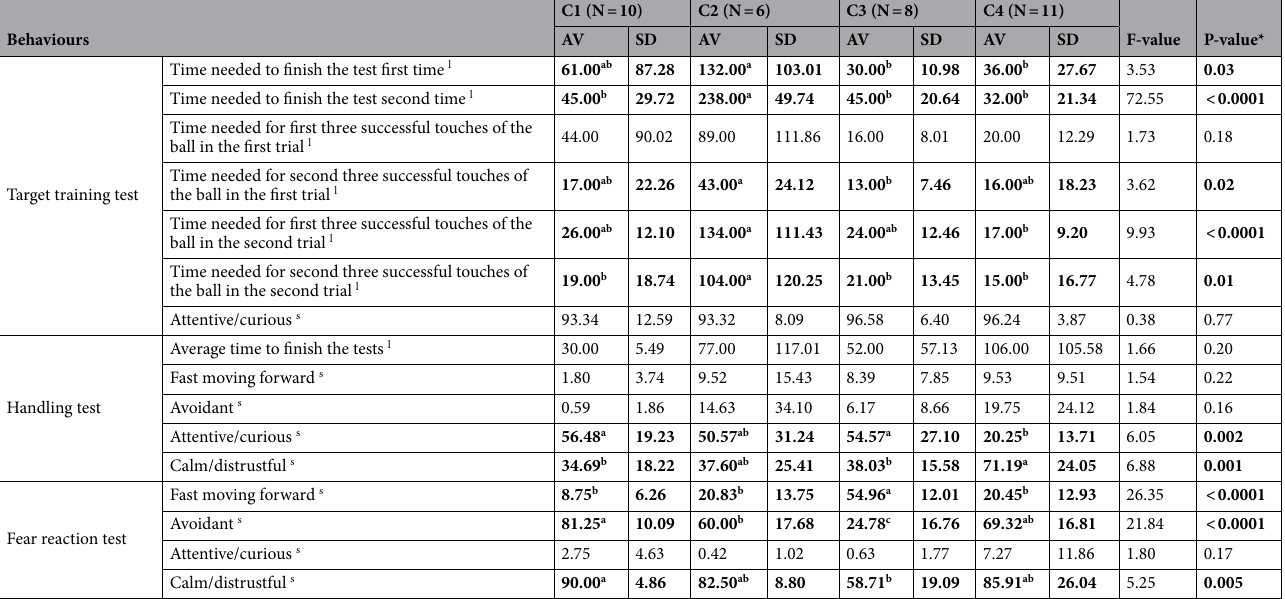
Table 2. Calculated average values (AV), standard deviation (SD), F-values and P-values for four groups of horses (C1—C4), derived from behavioural data in the behavioural tests. C1—intermediate horses; C2—low trainability horses; C3—low fearful horses; C4—horses with low cooperation. Pair-wise differences between the four groups are indicated by different superscript letters, with "a" representing the highest AV. l Values represent latencies, measured in seconds (s). s Values represent percentage (%) of the total testing time. *Pair- wise behavioural results of the horses with statistical significance at 0.05 (p < 0.05/6) in bold.